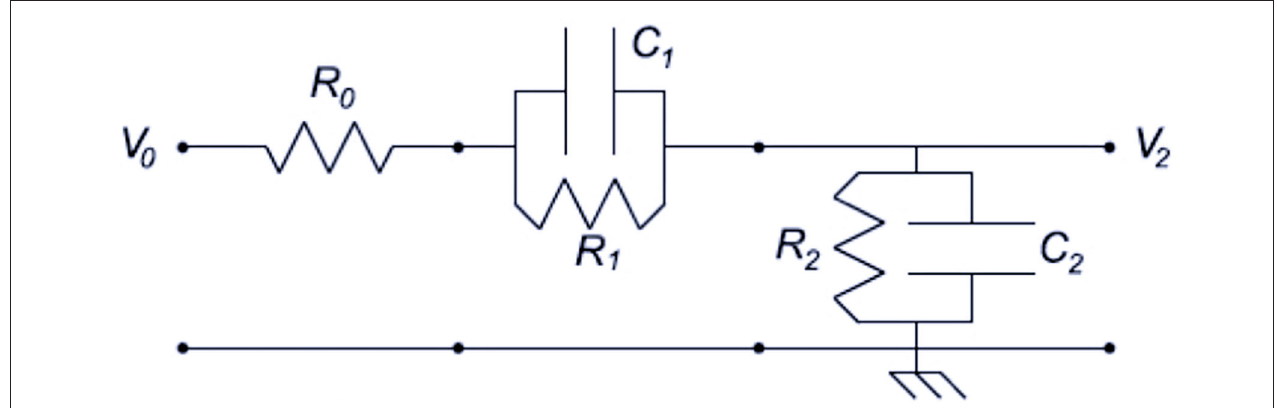
FIGURE 2 | Pair of leaky capacitors analog circuit [16].